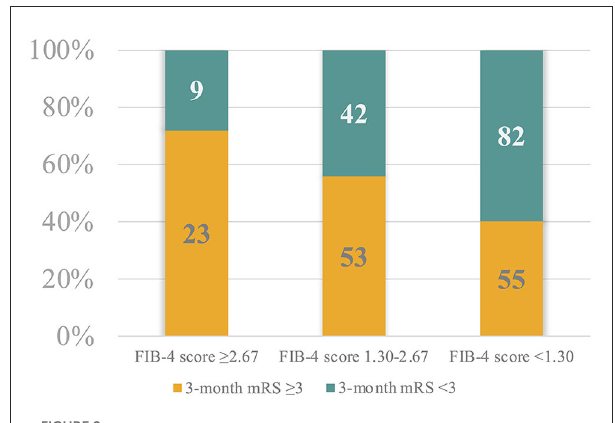
FIGURE2 Patient proportional distribution based on the FIB-4 score cut-off values and the 3-month modified Ranking